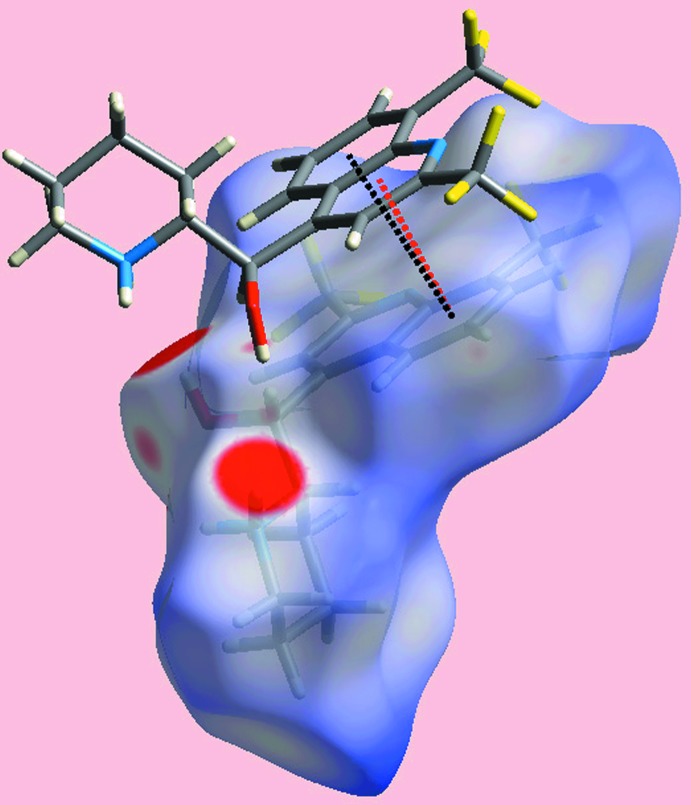
A view of Hirshfeld surface mapped over d
norm for the O1-containing cation in the range −0.229 to + 2.242 arbitrary units highlighting the intra­molecular π–π contacts between the (C4–C9) ring of the O1-containing cation and the (C21–C26) and N3-pyridyl rings of the O2-containing cation by red and black dotted lines, respectively.